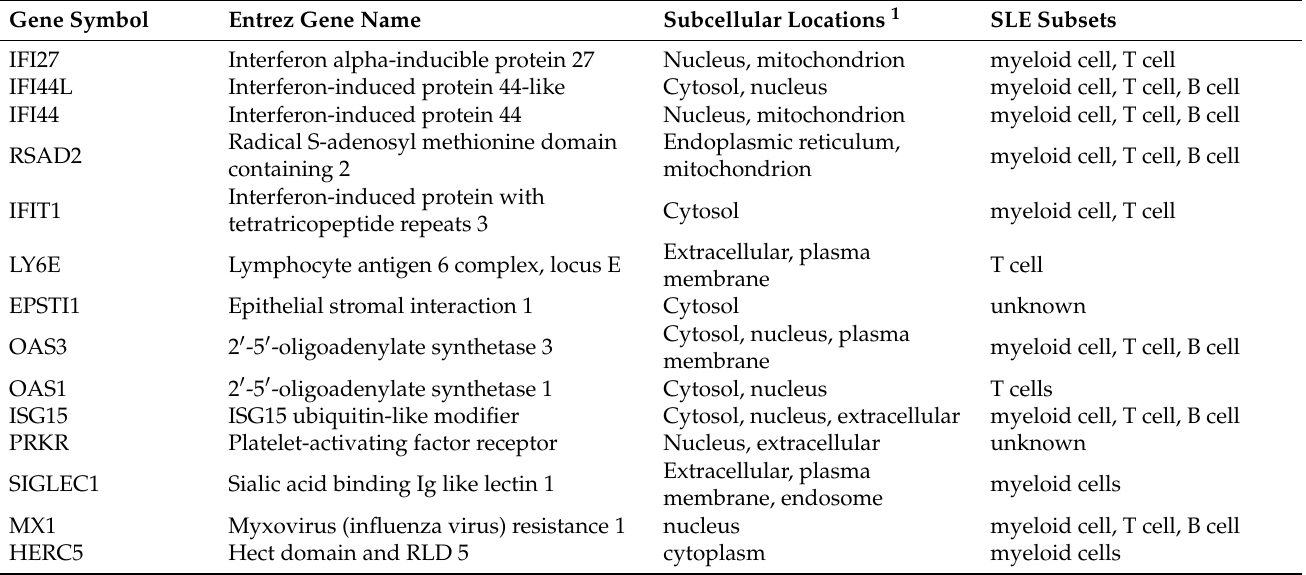
Table 1. Common interferon- α -inducible genes in systemic lupus erythematosus